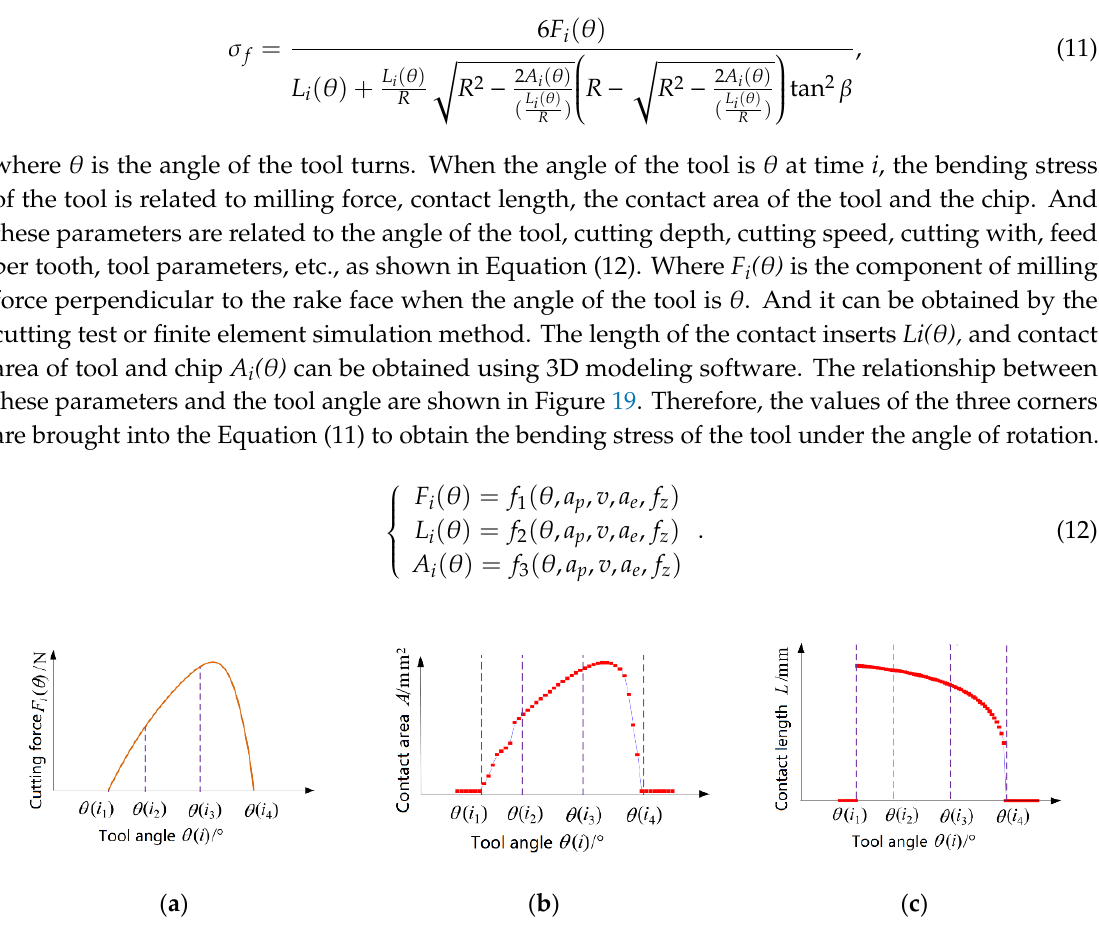
Figure 19. Correspondence relationship in different tools angles between cutting prameters: ( a ) cutting force; ( b ) contact area; ( c ) contact edge length.